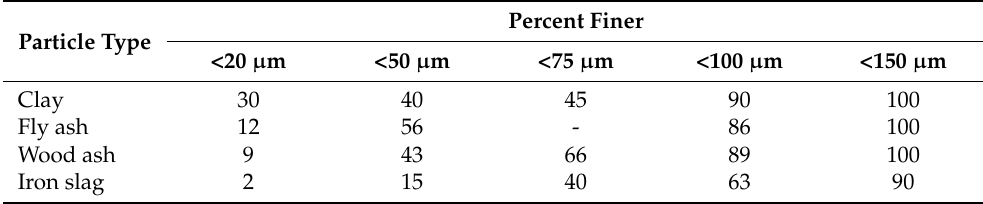
Table 5. Grain size distribution of constituent materials.